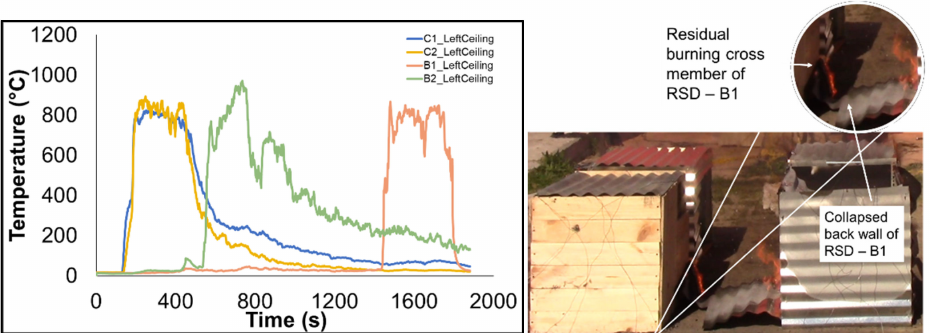
Figure 21. Six RSD experiments—left: ceiling temperatures of RSDs in test 19; right: burning of residual cross